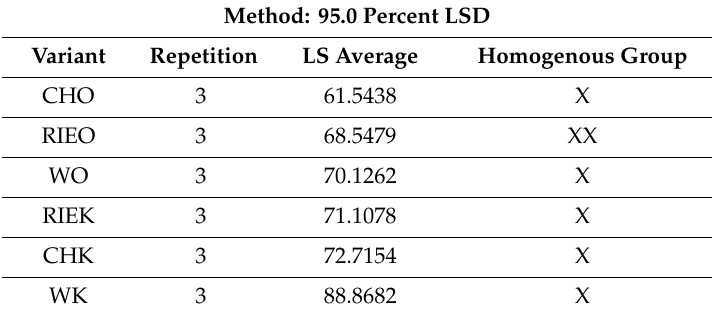
Table 8. Influence of the variety and the variant on the total content of 19 investigated phenolic substances.